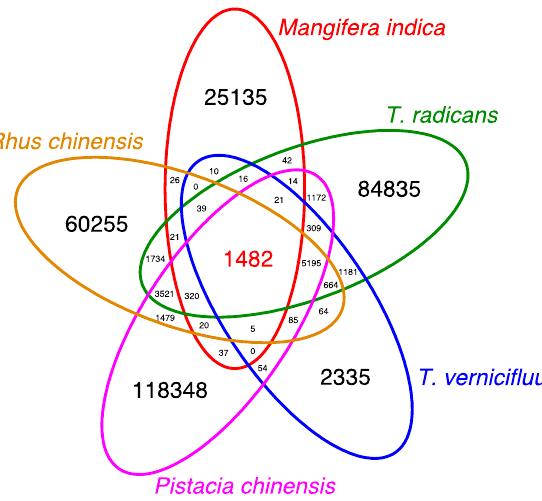
Figure 6. Anacardiaceae pan-transcriptome Venn diagram. Counts of orthologous transcripts shared by one or more members of Anacardiaceae are represented in each segment. The count of orthologous transcripts shared by all (core) is colored red. Regions are not to scale.